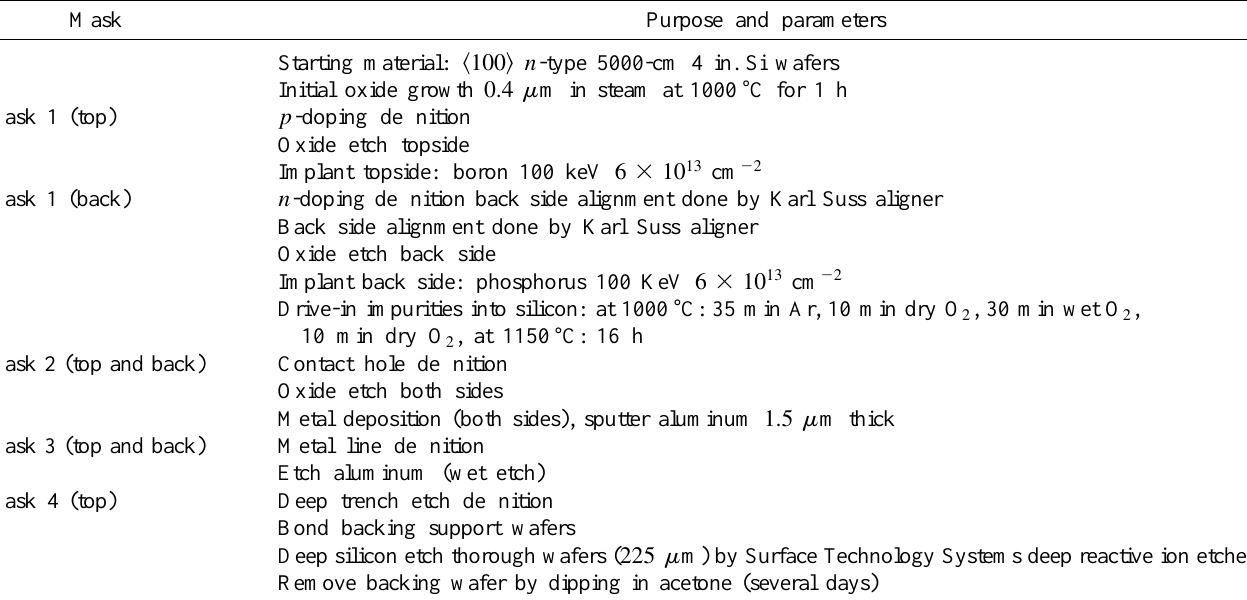
TABLE I. Process flow for p - i - n (cid:1) n - i - p diode array active